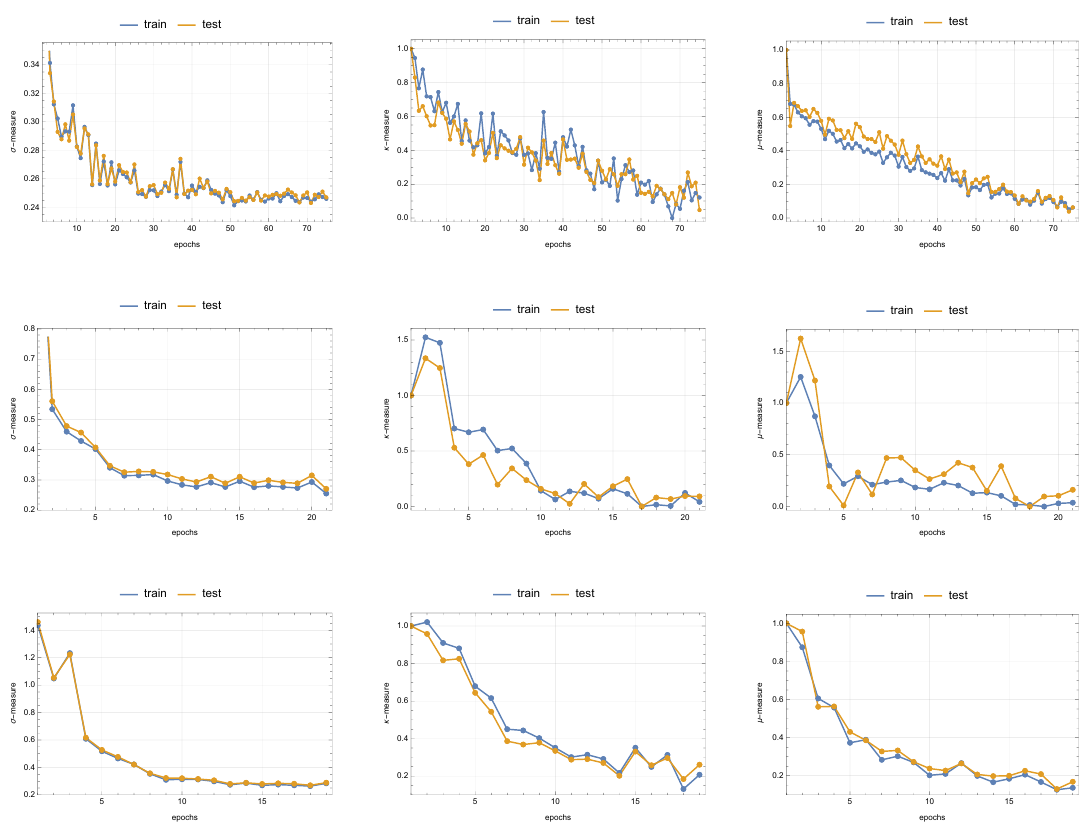
Figure 9 . Evolution of the σ , κ , and µ -measures as defined in section 6.2, for the Fermat quin- tic (2.6). For ease of visualization, the σ measure is reported in the original scale, whereas the other measures are reported in the log scale after a normalisation. Our architecture is a set of two three layer networks with 500 nodes in each layer and tanh activation (see figure 2). We use a train-test split of 90 : 10 . We use variable training sizes: 28 , 000 points in the case of the top row, and 10 , 000 points for the bottom two rows. We use a batch size of 500 , a learning rate of 10 − 4 (rows one and two) and 10 − 3 for the bottom row. The loss function is a weighted combination of all three measures. In all these cases, the σ measures fall below the corresponding σ measure for the pullback of the Fubini-Study metric. These graphs illustrate the robustness of our architecture and methodology in obtaining approximations to the Kähler, Ricci flat metric on the Fermat quintic. Remarkably, a small number of epochs are sufficient to achieve this